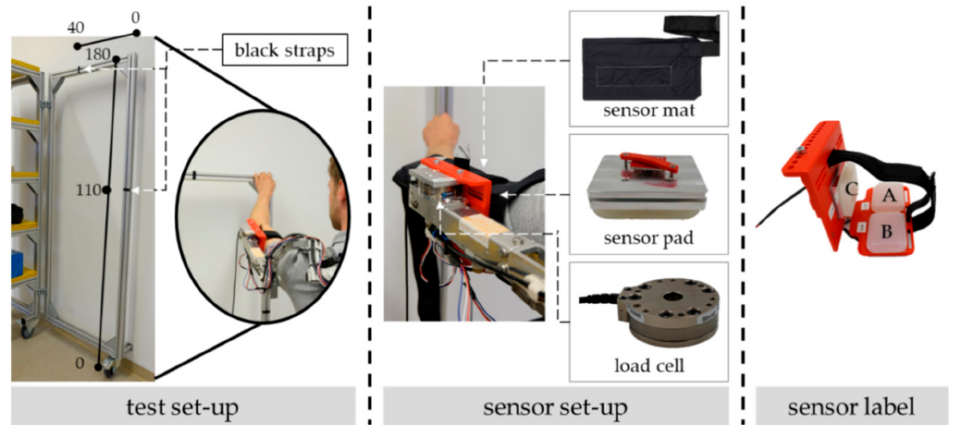
Figure 4. Illustration of the arranged comparing measurement equipment consisting of sensor mat and load cell as well as of the aluminum frame with black straps for marking motion endpoints. The dimensions are given in